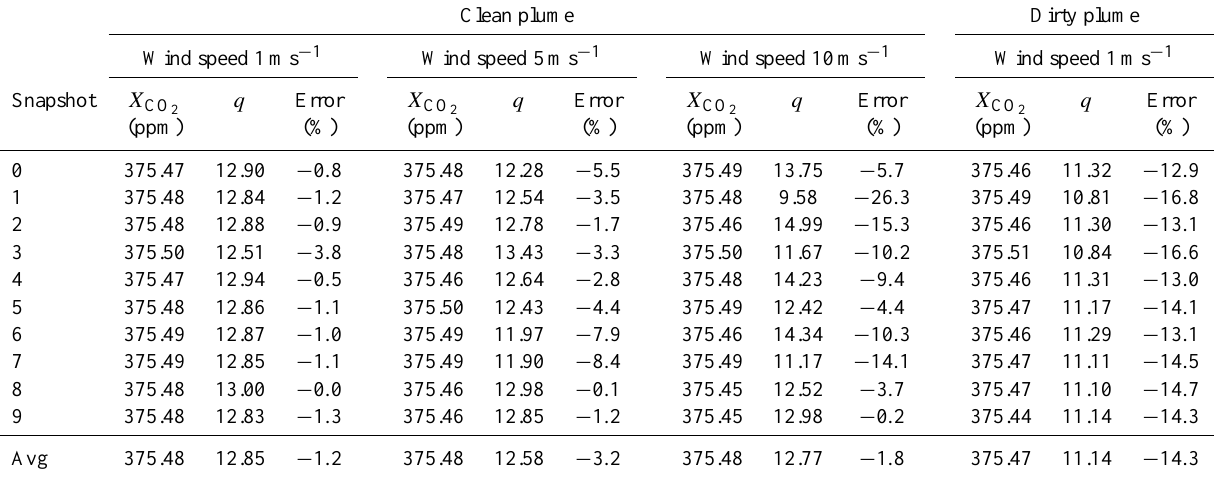
Fig. 19. As for Fig. 18 except that the plume is assumed to contain aerosol with optical thickness proportional to the X CO 2 enhancement. At the maximum CO 2 enhancement, the extra optical thickness of aerosol is 0.15 at the blue end of the O 2 A-band.